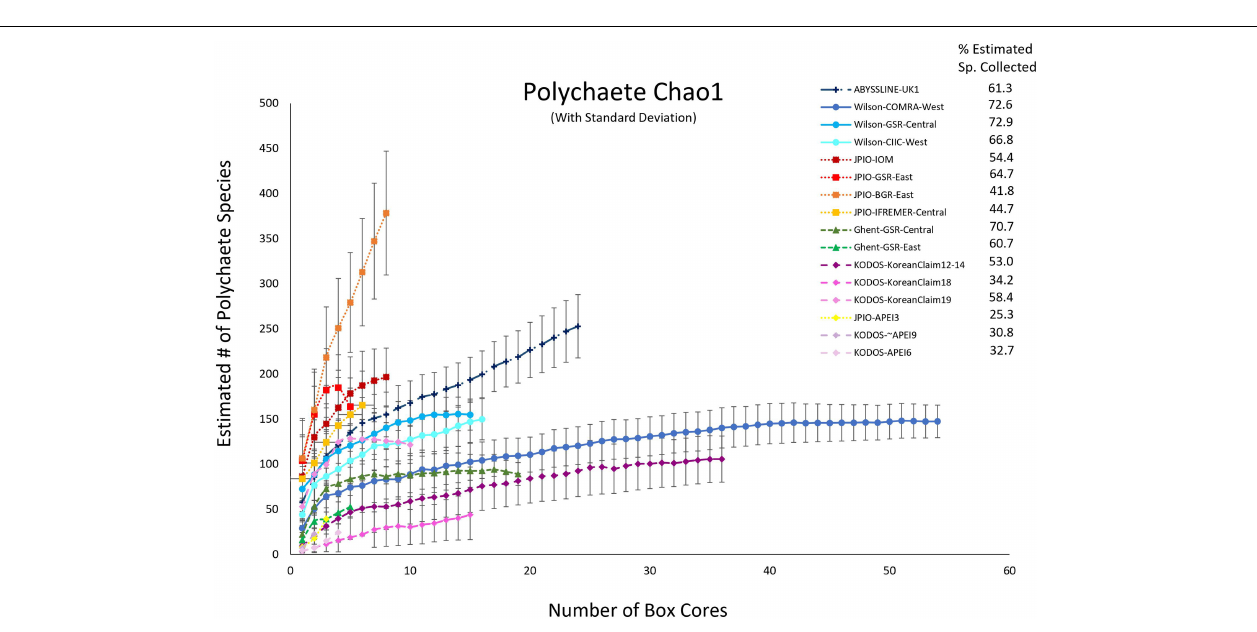
FIGURE 5 | Percentage of total polychaete species represented by singletons + doubletons in pooled collections from each site and study. The total number of polychaete species collected in each data set is indicated at the top of each bar. Note that KODOS-KoreanClaim data come from a single site sampled in different years, and potentially with different sampling efficiencies. Data sets considered to have been sampled with similar protocols and to have used a consistent taxonomy are indicated by similar colors.